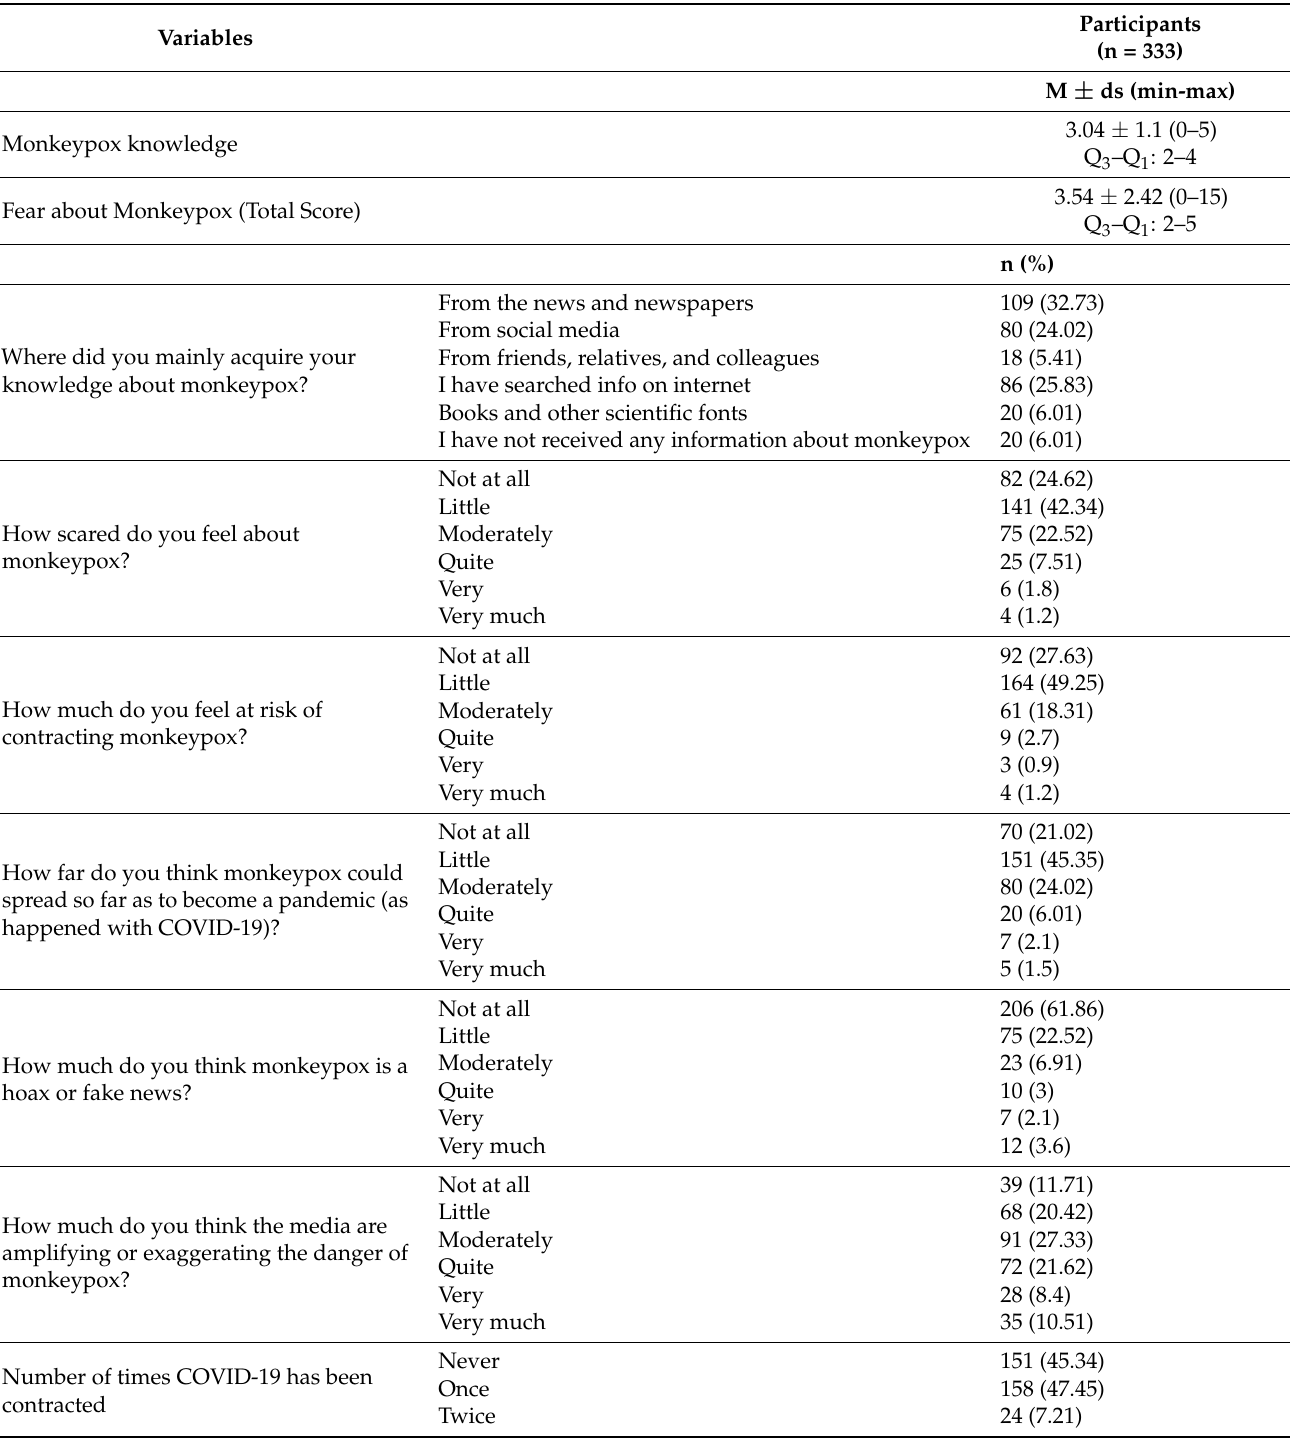
Table 2. Monkeypox and COVID-19 variables